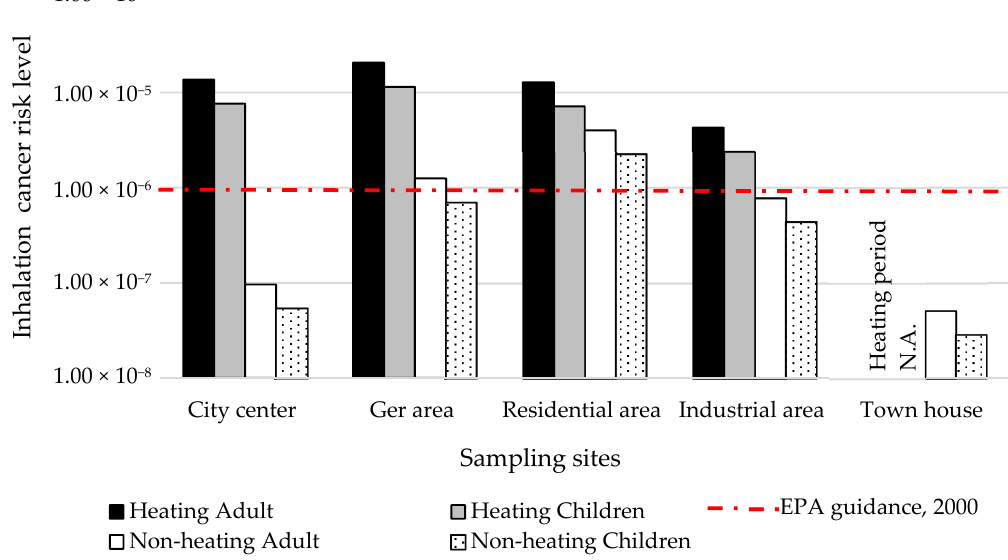
Figure 7. Estimated lifetime inhalation cancer risk attributed to measured concentration of PAHs in the ambient air of different sampling sites of Ulaanbaatar City.